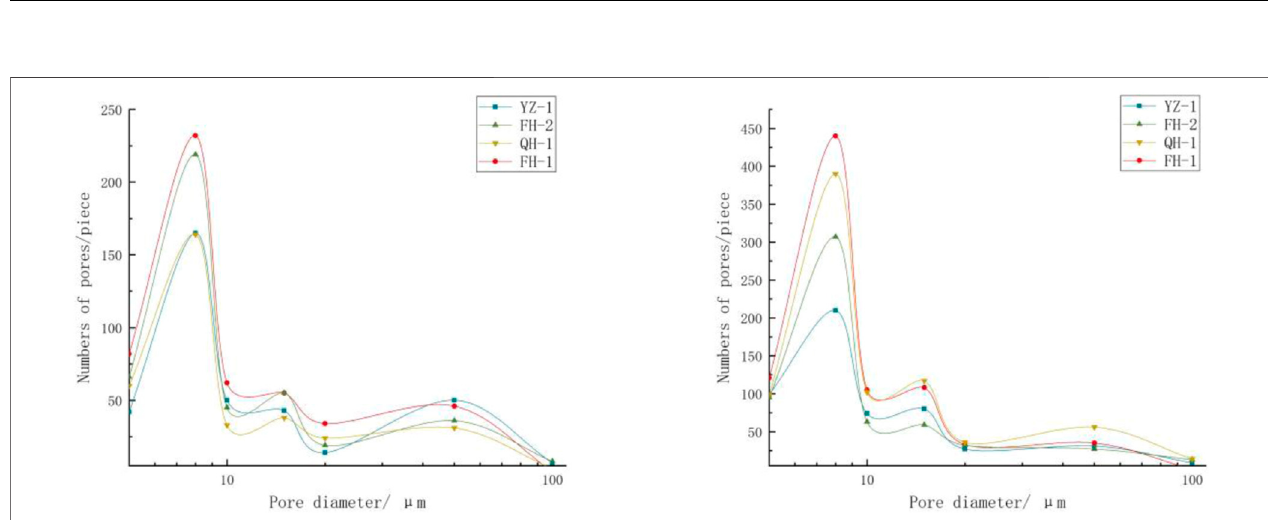
FIGURE 4 | Statistical graph of the pore size – quantity distribution of various samples. After the seismic subsidence test, the large and medium pores are almost completely eliminated due to the application of the modi fi ed method and the effect of cyclic load.